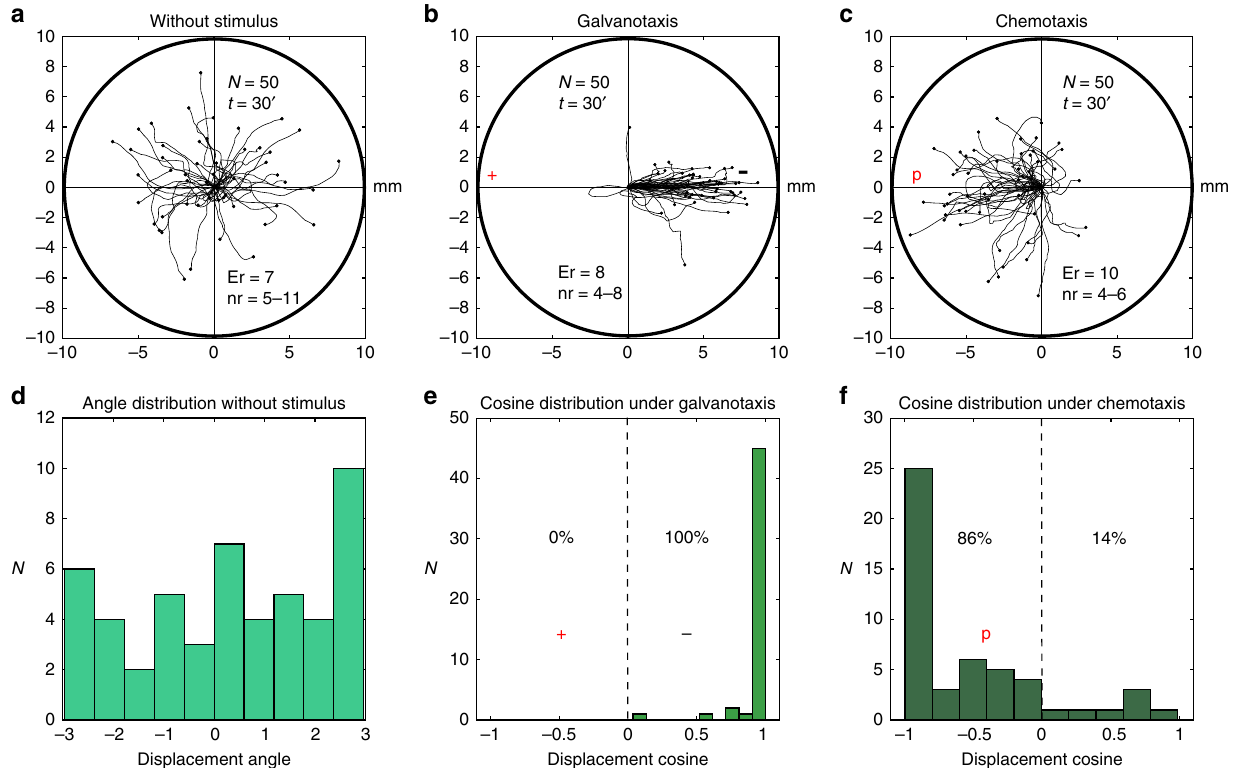
Fig. 3 Migration trajectories of Amoebae proteus under three basic and independent experimental conditions: without stimulus, galvanotaxis and chemotaxis. a Trace – without stimulus. Without stimulus the cells practically explored all the directions of the experimentation chamber. b Trace – galvanotaxis. Under galvanotaxis conditions practically all the amoebae migrated towards the cathode. c Trace – chemotaxis. Under chemotaxis conditions, 86% of the cells migrated towards the chemotactic gradient. d Plot of displacement angle for a. Distribution of displacement angles (i.e., the angle formed between the origin and the end of the movement, measured in radians) for the trajectories without stimulus ( a ). No preference towards a certain direction was appreciated. e Plot of displacement angle for b. Distribution of the cosines of displacement angles for the trajectories under galvanotaxis ( b ). 100% of the displacement cosines were bigger than 0, indicating a strong directionality towards the cathode. f Plot of displacement angle for c. Distribution of the cosines of displacement angles for trajectories under chemotaxis ( c ). “ N ” total number of cells, “ Er ” experimental replications, “ nr ” number of cells per replication, “ t ” time of galvanotaxis or chemotaxis, “ p ” chemotactic peptide (nFMLP), “ + ” anode, “ − ” cathode. Both the x and y axis show the distance in mm, and the initial location of each cell has been placed at the center of the